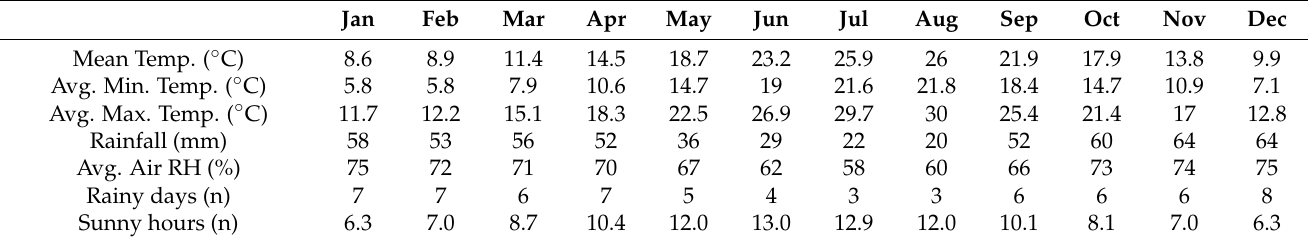
Table 1. General climate features of the trial area (avg. 1999–2019, Climate-Data.Org) [34].